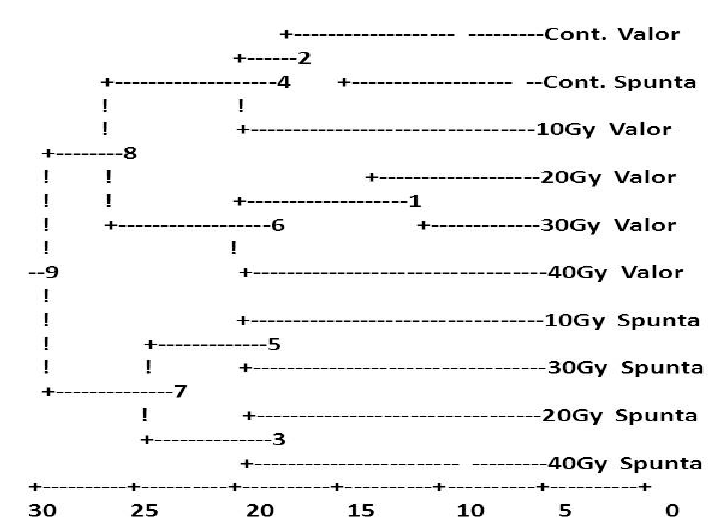
Fig. 5. Dendrogram of ten gamma radiation doses treatment of potato cvs. ‘Valor’ and